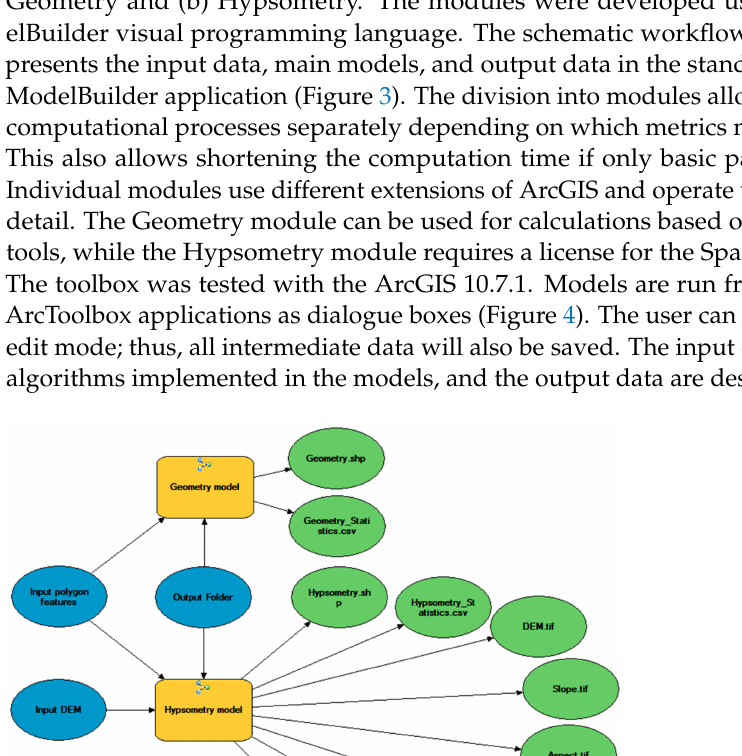
Figure 4. The interface of the MAT toolbox. 3.2.1. Input Data Requirements The first input data set for the analysis is the boundary of the landform. The bound- aries should be prepared as polygons and saved as an ESRI Shapefile (.shp) or geodata- base feature class. The boundary line should be situated on the edges of the concave form (Figure 5). The landform edge polygon can be created manually using vectorisation